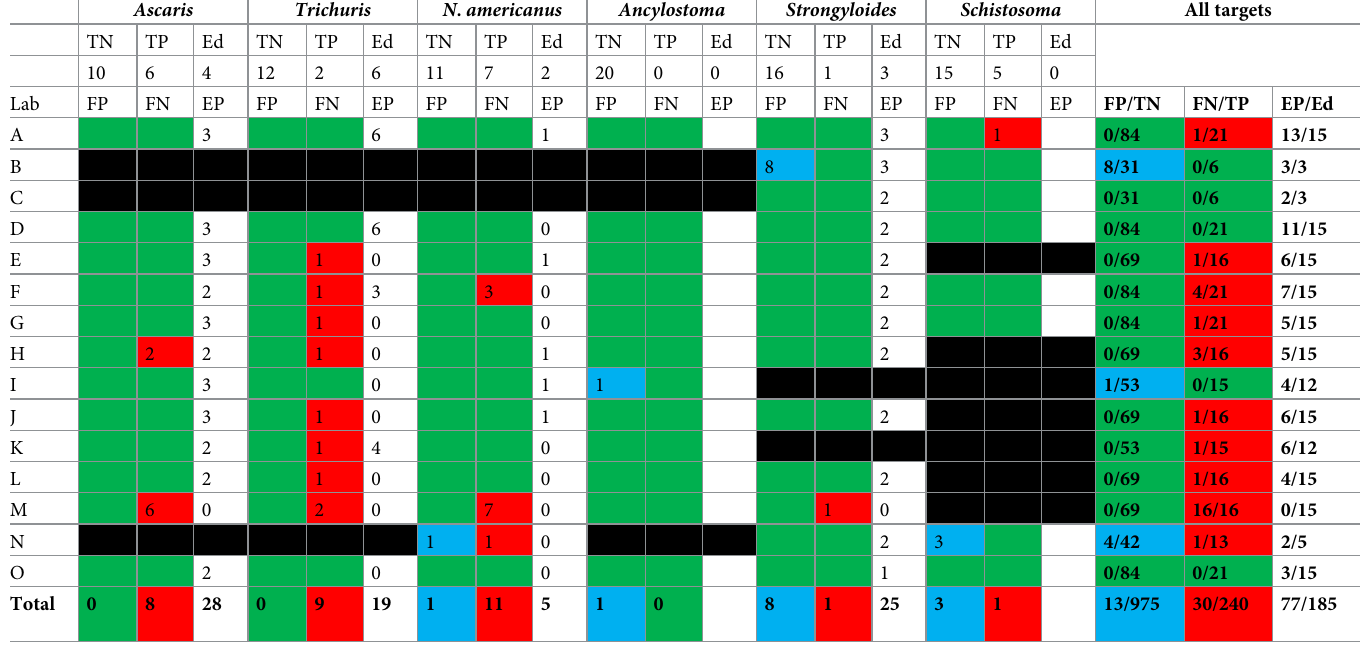
Table 5. The performance of 15 laboratories for the detection of six helminths in stool and DNA. The numbers in the second row represent the total number of true negatives (TN), true positives (TP) and educational samples (Ed) per target. The laboratories are shown in the left column. The body of the table shows the number of false-positive (FP), false-negative (FN) and educational (Ed) test results per laboratory and per target. Blue cells indicate FP results, red cells indicate FN results, green cells indicate the absence of FP and FN results, black cells indicate that a NAAT has not been performed by a laboratory. The numbers in the blue, red and white cells indicate the number of FP, FN or Ed results, respectively. The ‘All targets’ column, represents per laboratory across all targets the ratio of the totals of FP, FN and educational posi- tives (EP) over the total number of TN, TP and Ed.